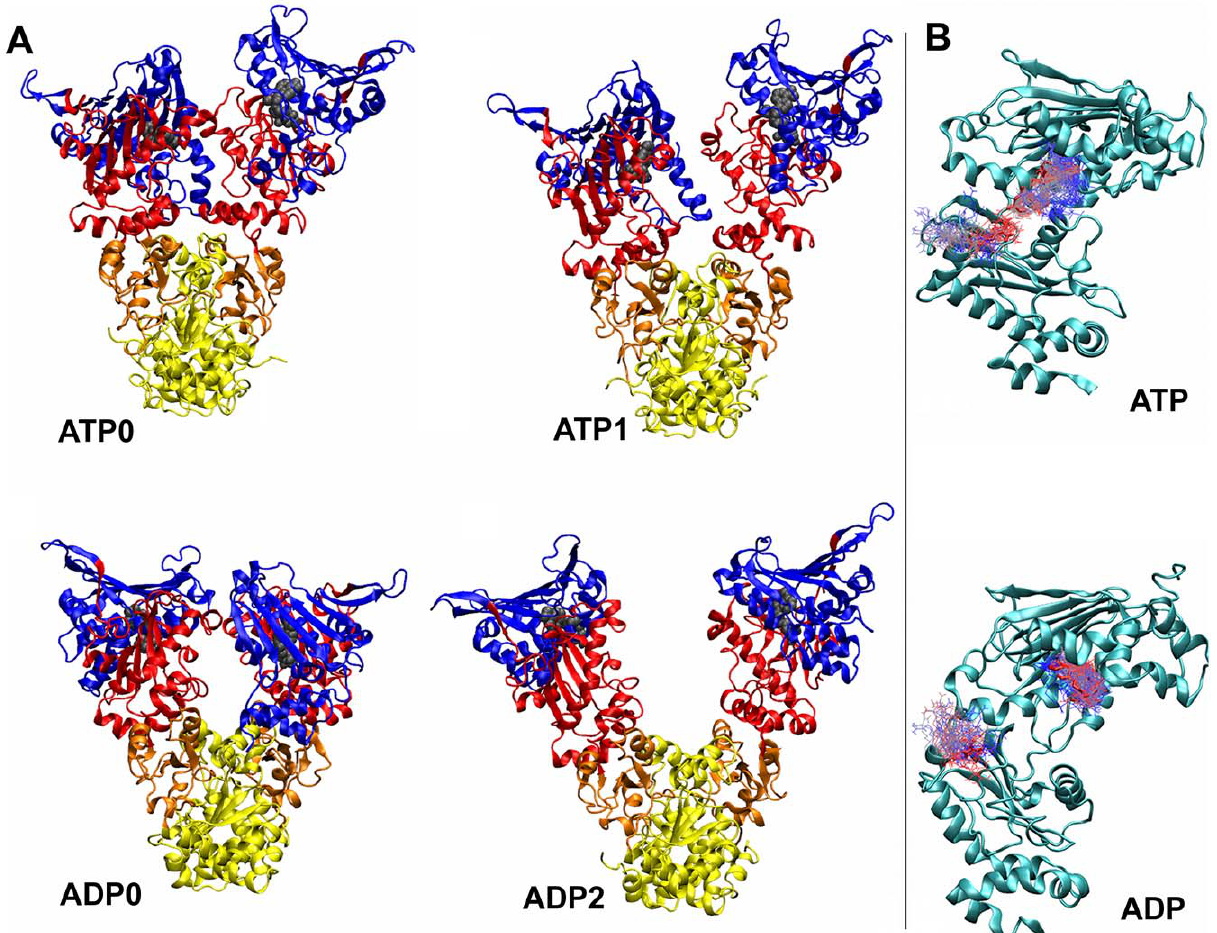
Figure 2. Representative structures of Grp94. A , Labels ATP0 and ATP1 show the representative structures of the two most populated cluster in the Grp94-ATP simulation. Labels ADP0 and ADP2 show the representative structures of the first and third most populated cluster in the Grp94-ADP simulation. The second cluster (not shown) represents the intermediate between ADP0 and ADP2, characterized by a slight rotation of the NTDs and an initial opening of the M-domains. B , trajectory snapshots showing the time evolution of the interaction between the nucleotide and Arg448 in the ATP simulation (top) and in the ADP simulation (bottom). Snapshots are color coded according to time evolution: from blue (0 ns) to red (100 ns).